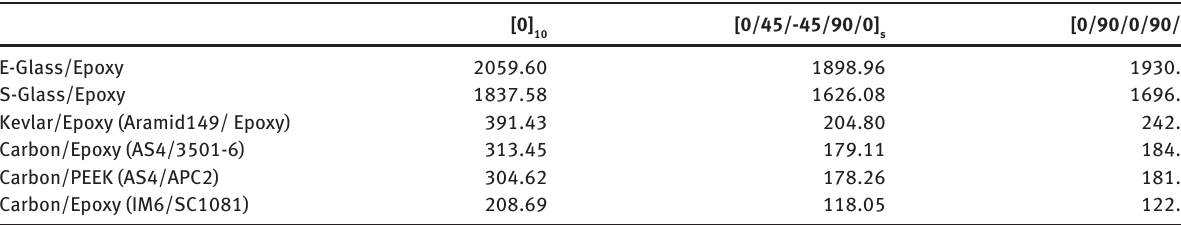
Table 11 Comparison of the critical energy release rate G (N/m) obtained from meshfree methods (Nodes: 11 ×